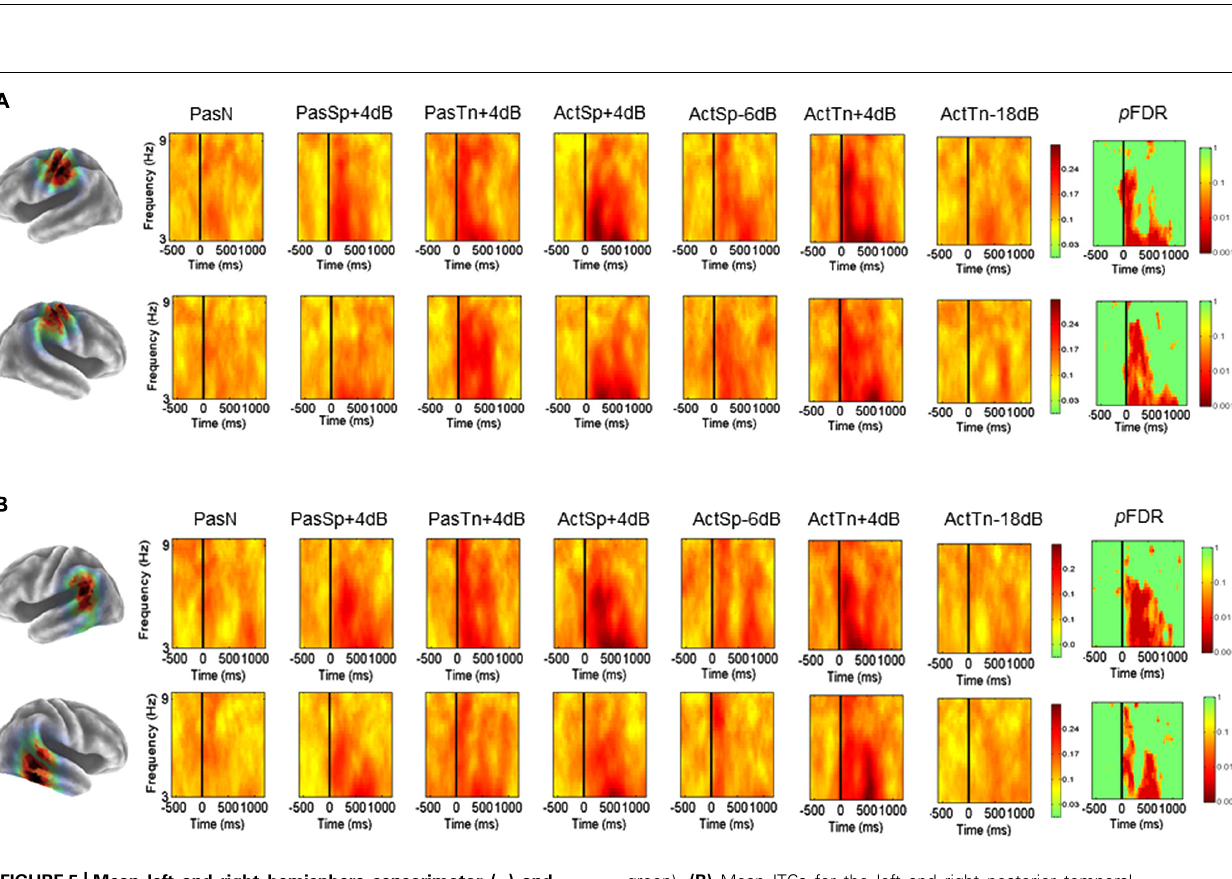
green). (B) Mean ITCs for the left and right posterior temporal component clusters as a function of condition with p -values corrected for false discovery rate in a separate map (non-significant values indicated in